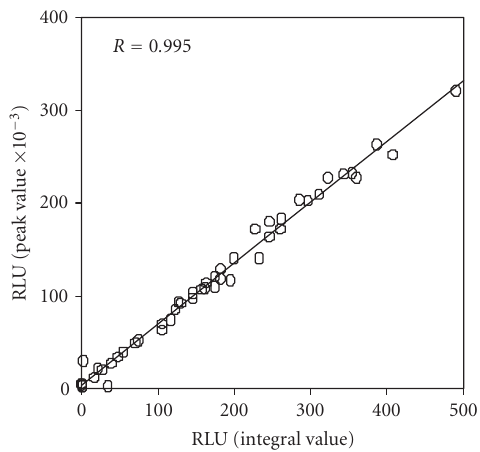
Figure 2. Correlation between the two parameters used to mea- sure chemiluminescence (CL) response of phagocyting leuko- cytes. Peak value represents the maximal signal intensity among the 30 measurement points, whereas the integral value is the to- tal integration of CL signals for a 30-minute period.